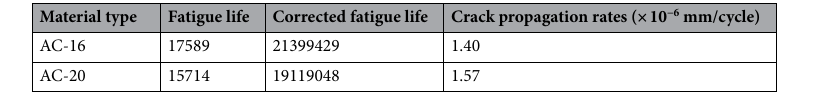
Table 4. Fatigue test results of different asphalt mixtures.